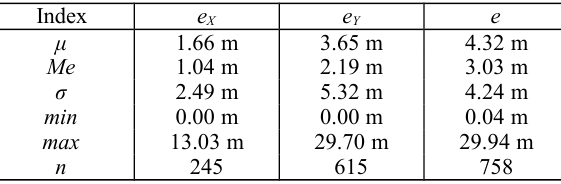
Table 2. Statistics on the planimetric error e and its components e X and e Y in the X and Y directions